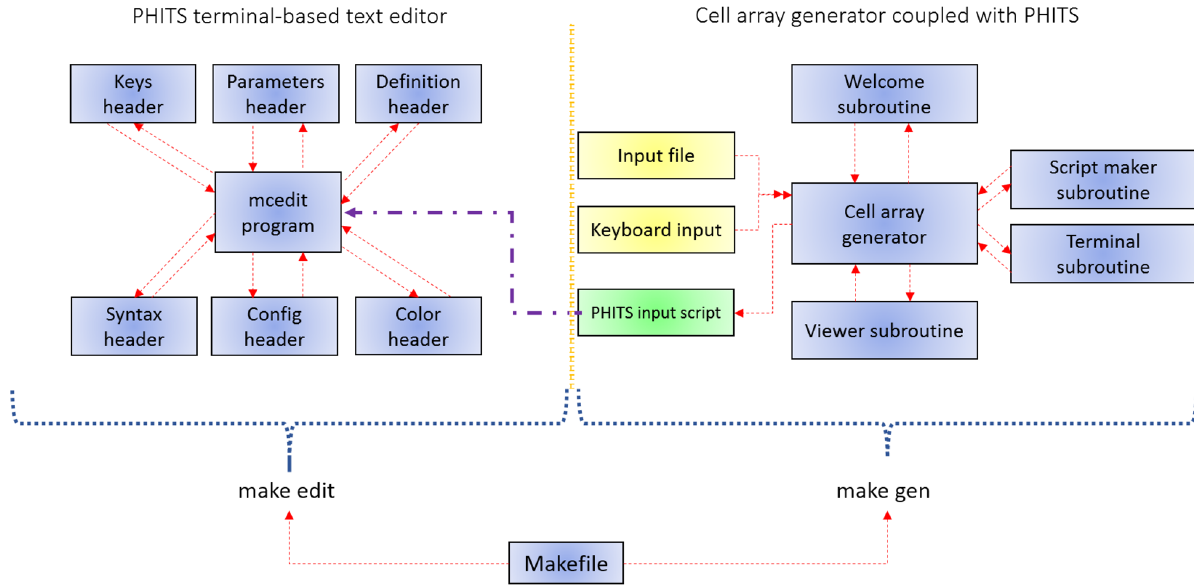
Figure 2. Flowchart of the cell array generator and PHITS text editor programs developed in the present work.